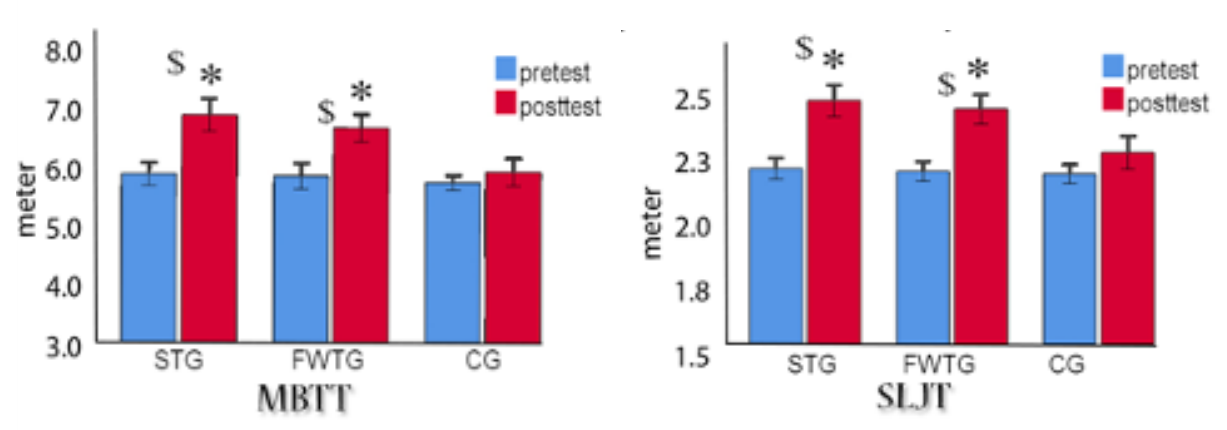
Figure 3. The effects of training intervention on SLJT. *significant difference from pre-test, $ significant difference from